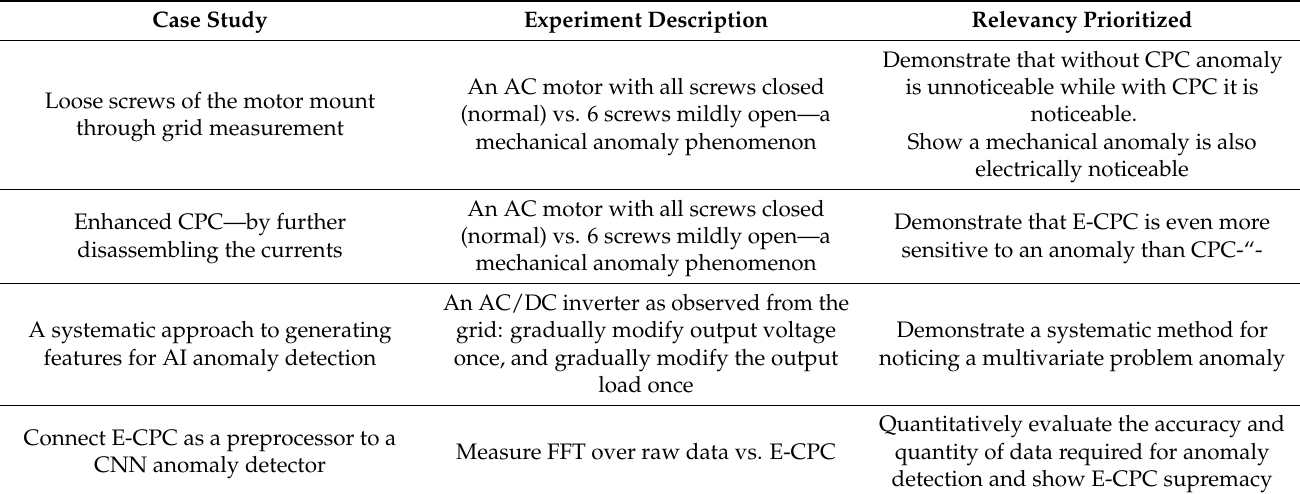
Table 1. Test cases and their relevance to presented